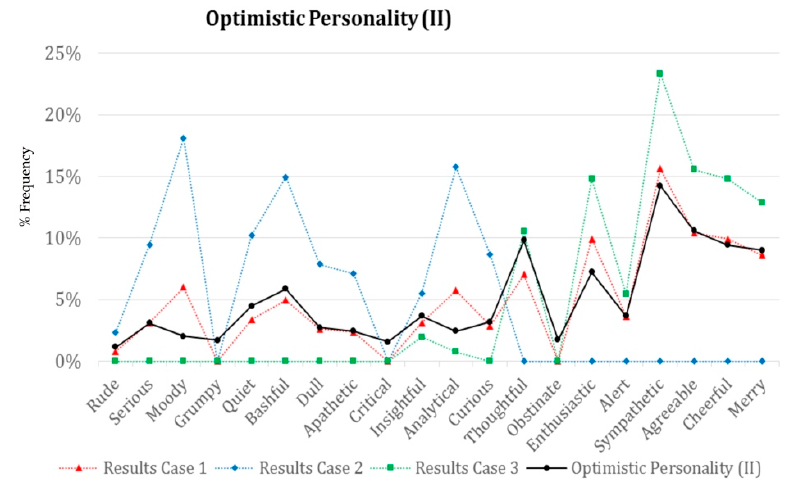
Figure 15. Comparison of cases for an Optimistic Personality.